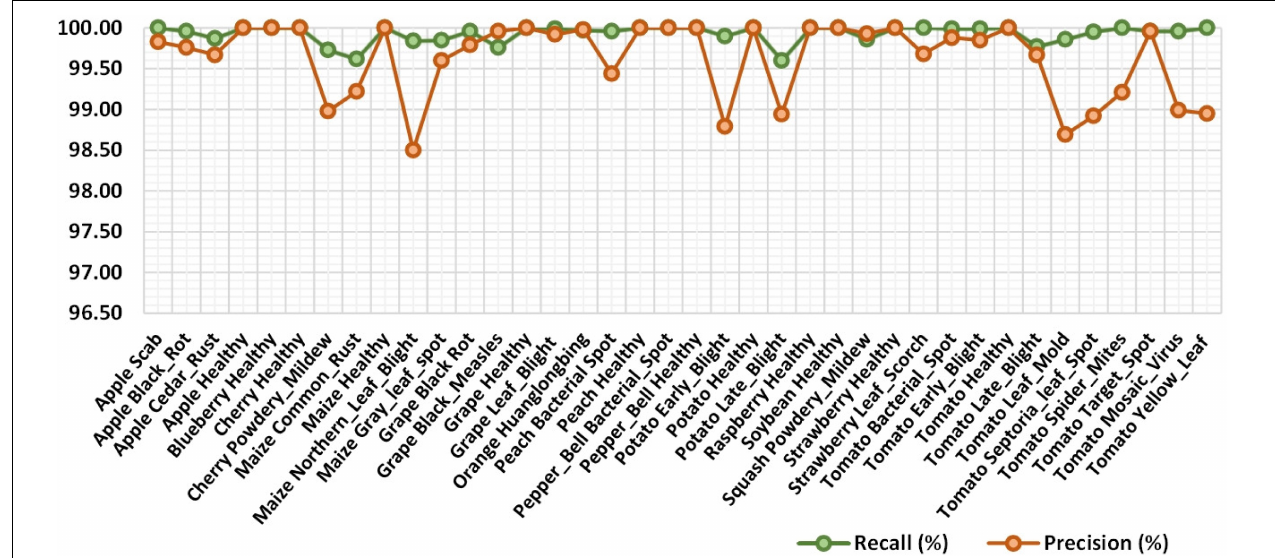
FIGURE 7 | Class-wise precision and recall values of the proposed